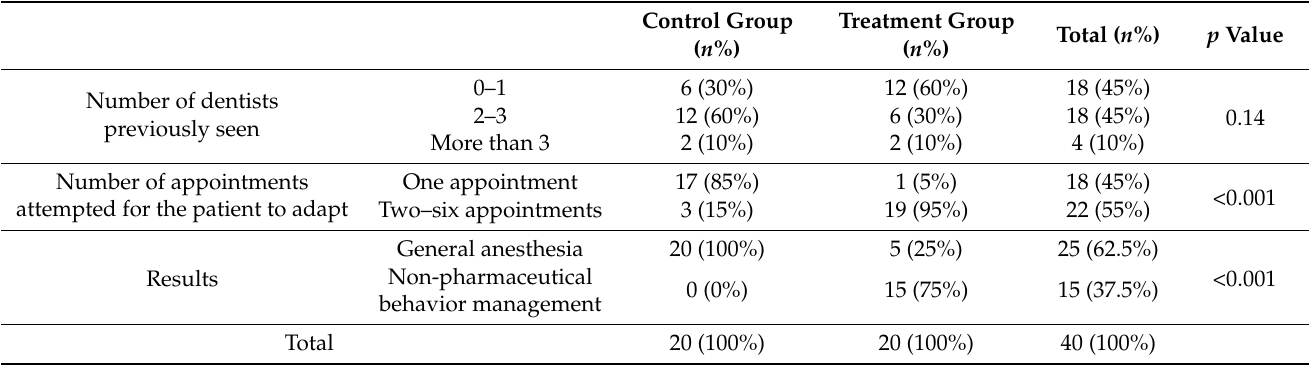
Table 2. Frequency of the number of previously seen dentists and the number of appointments